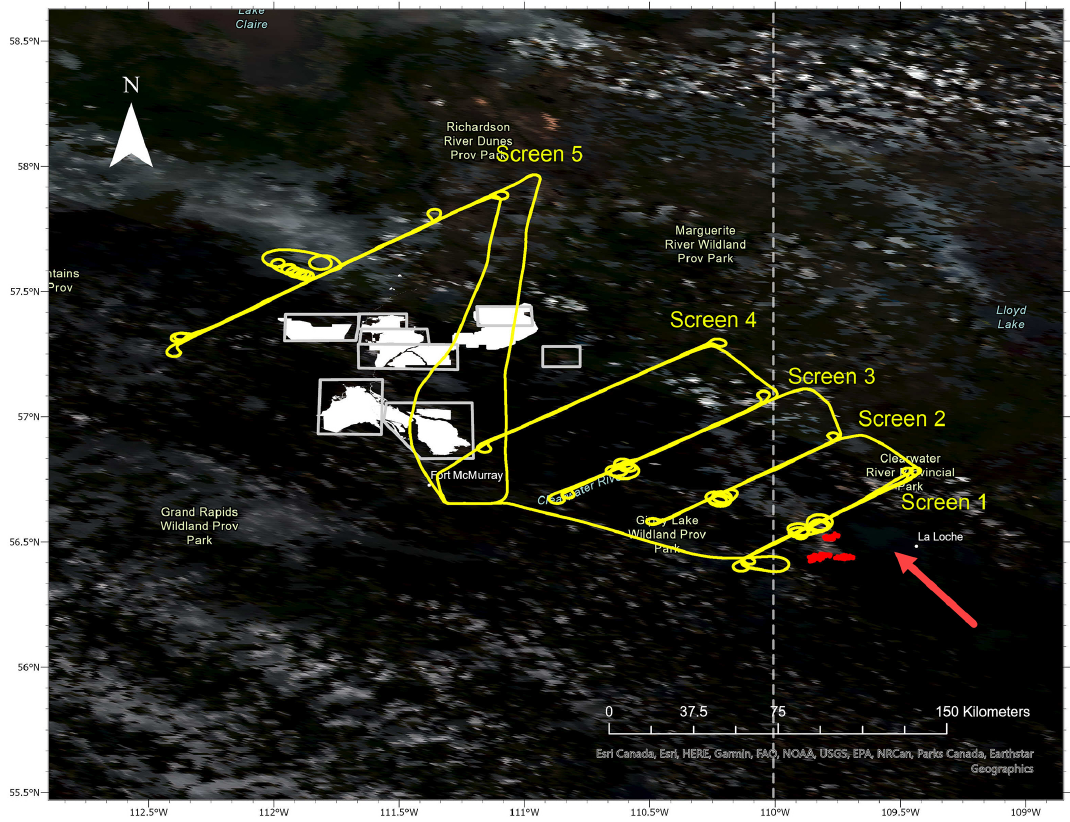
Figure 1. Corrected reflectance satellite image from the VIIRS spectroradiometer on the Suomi NPP and NOAA-20 satellites taken on 25 June 2018. The fire hot spots for the wildfire of interest are indicated by the red dots. Flight tracks were flown at Lagrangian distances downwind of the wildfire. Multiple transects at varying altitudes perpendicular to the plume direction formed five virtual screens. Plume direction of travel is indicated by the red arrow. The location of the Alberta oil sands mining facilities are shown in